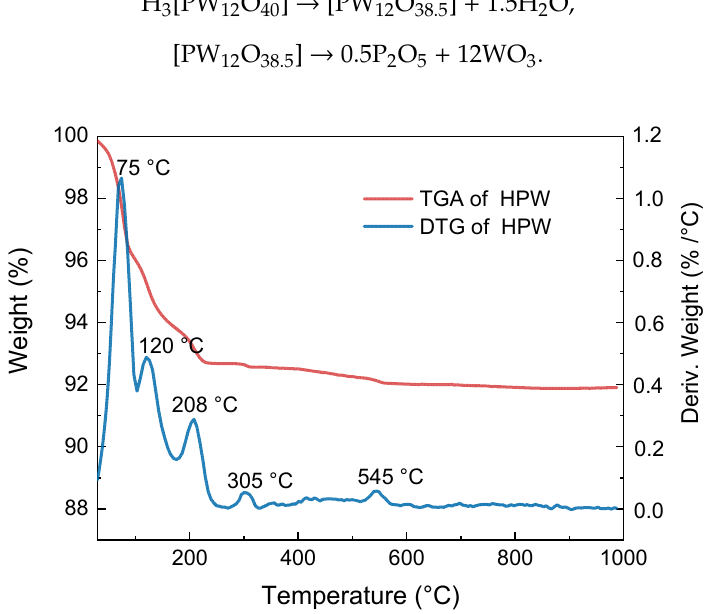
Figure 2. Thermogravimetric analysis (TGA) and derivative thermogravimetry (DTG) analysis of HPW samples.